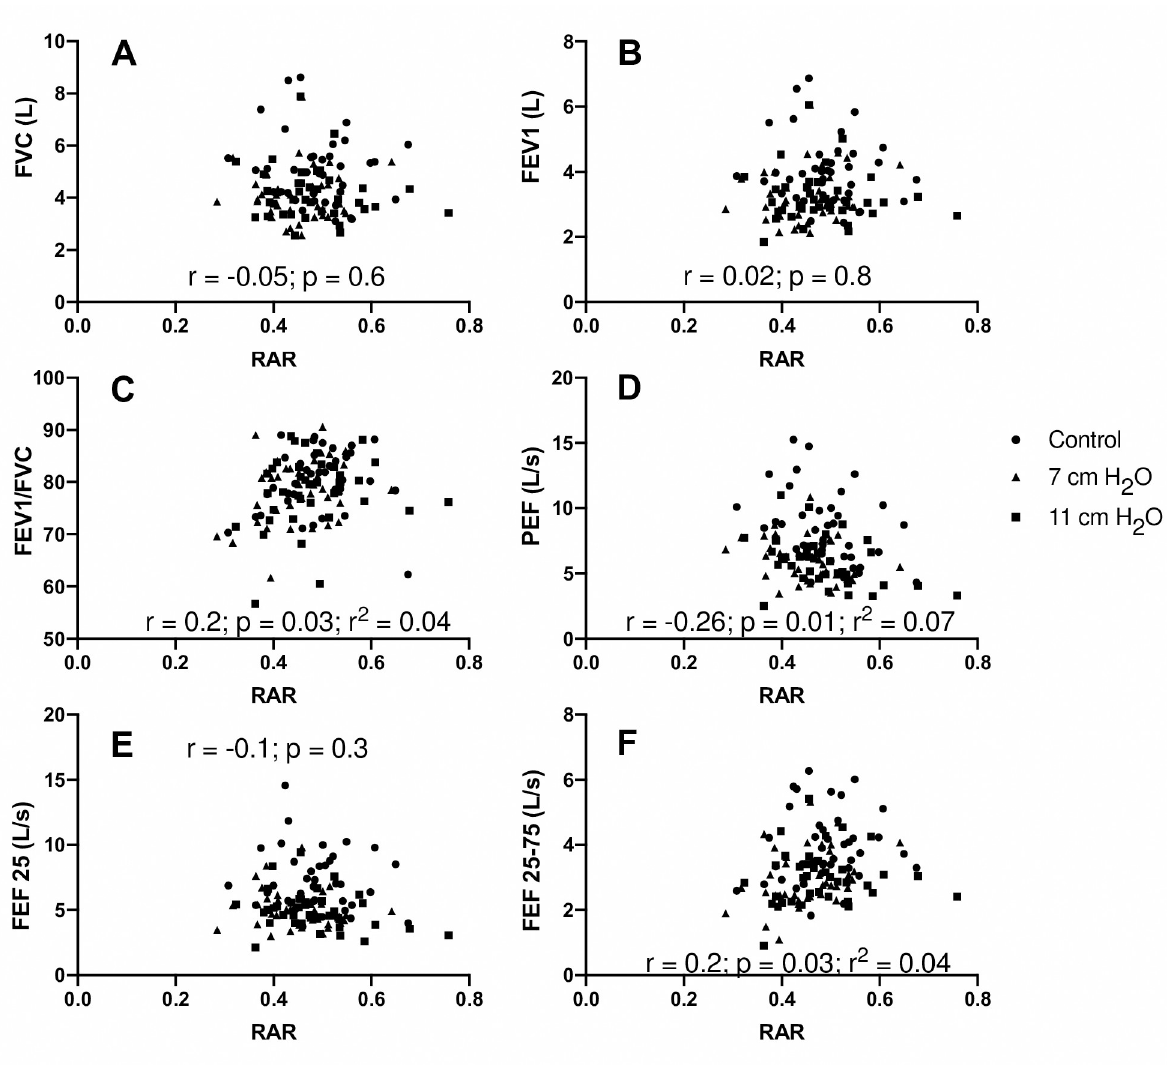
Fig 6. Rectangular Area Ratio (RAR) vs individual primary pulmonary function variables measured with and without imposed expiratory loading. Panels C, D, F show a correlation but one that is of no clinical importance. Pearson, p value, and where appropriate the coefficient of determination is included on the